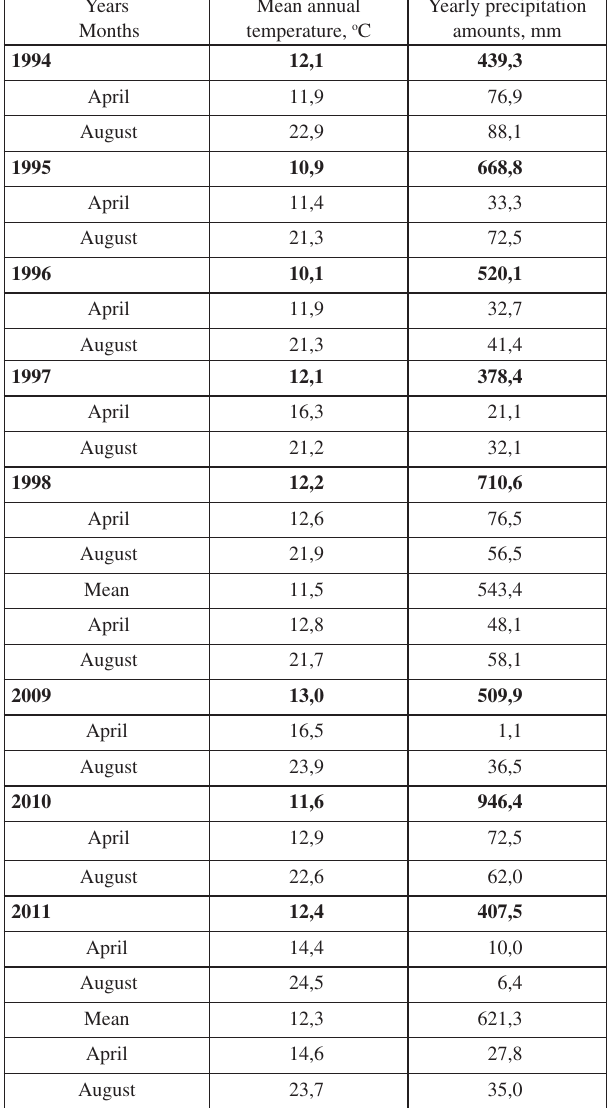
Table 1. Typical meteorological data measured during the tests (Data of 519 th Meteorological Station, at Cegléd) Years